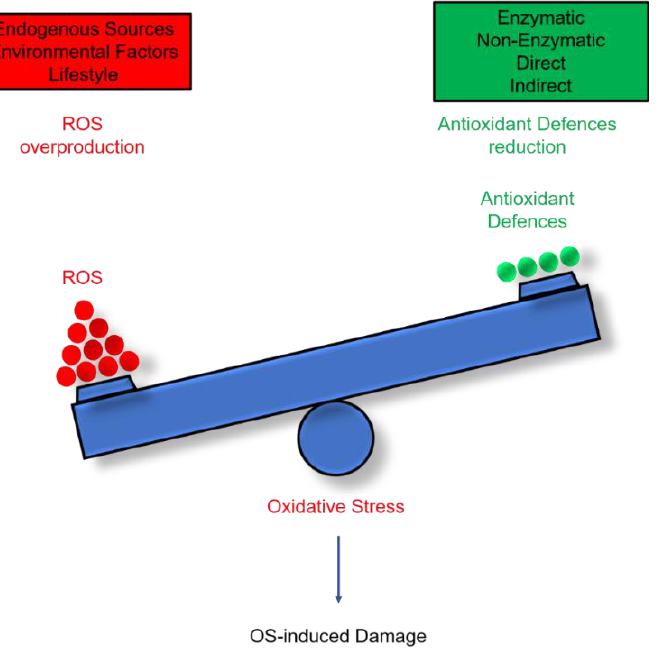
Figure 4. The RedOx balance is preserved by the existing equilibrium between ROS production rate and antioxidant defence systems. Highlighted in red are possible sources of ROS; and in green, the antioxidant defences. Oxidative stress (OS) occurs when there is an overproduction of ROS or a reduced ability of antioxidant defences to counteract the production of ROS. Oxidative stress can induce cellular and tissue injury.